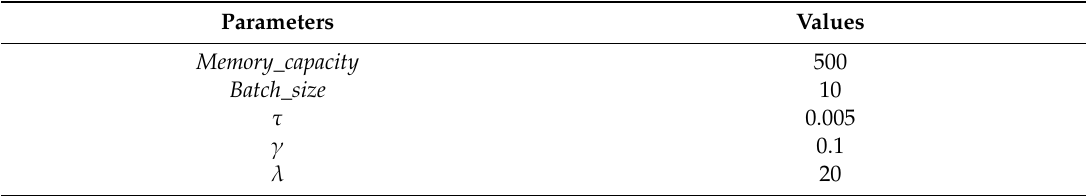
Table 2. The set of parameters in experiment